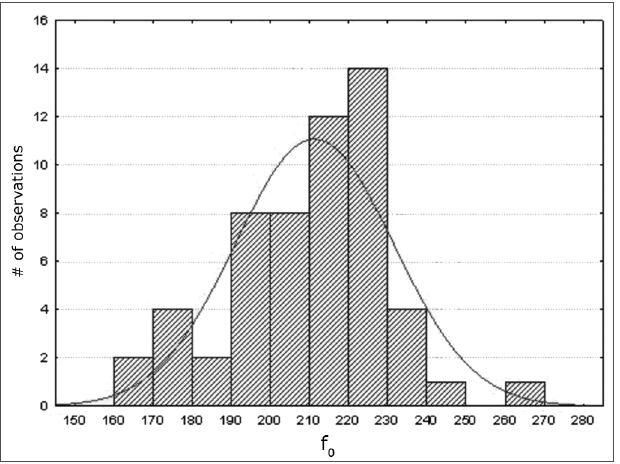
Figure 4. Normal distribution of jitter (ppq5) -